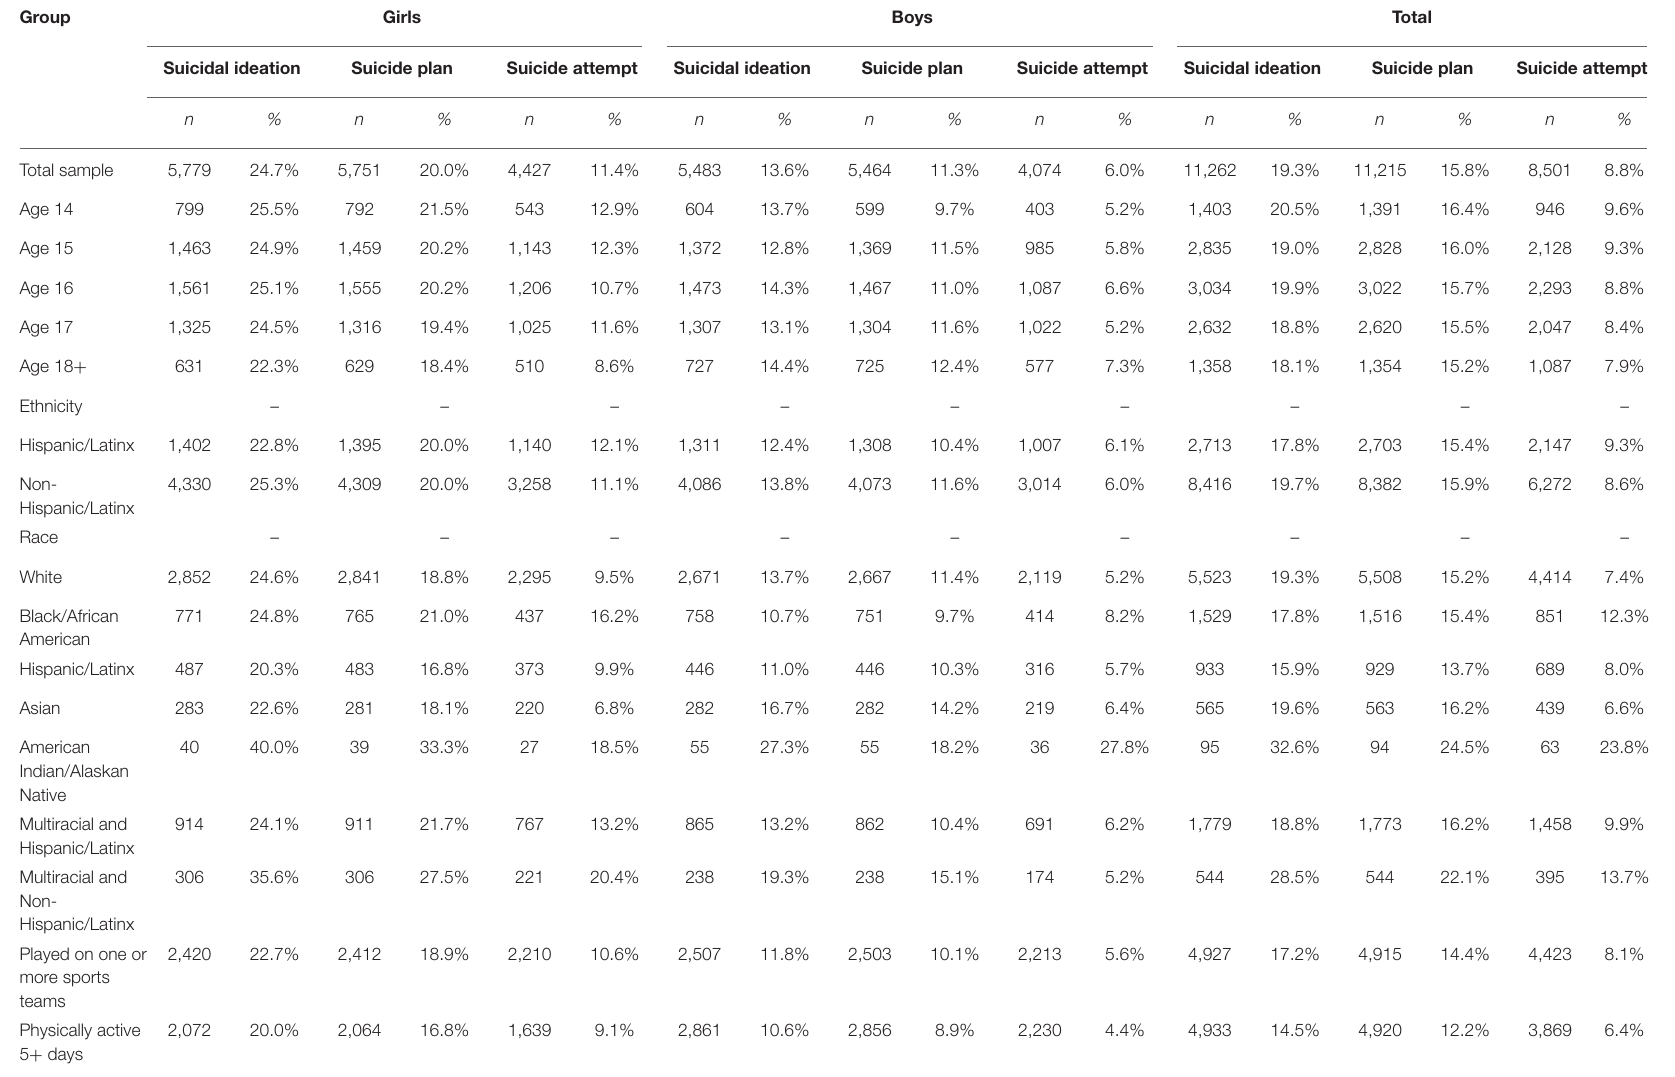
TABLE 2 | Percentages of high school students endorsing suicidality.